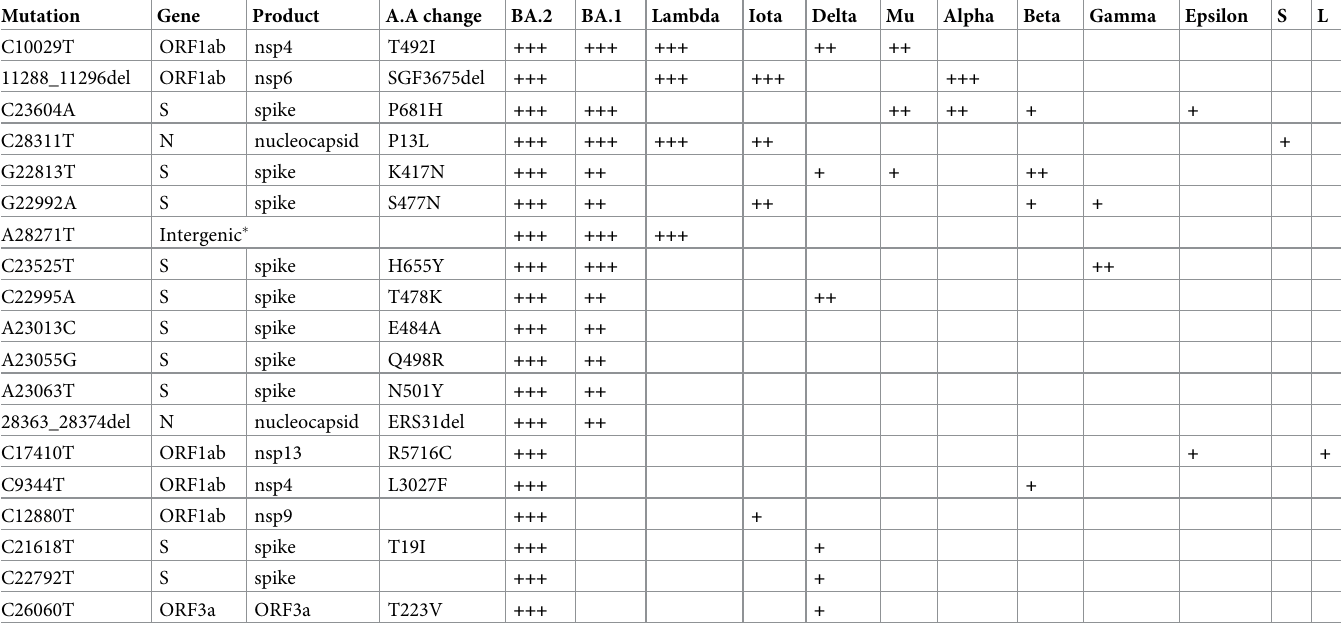
Table 1. Mutations shared between Omicron and some of other